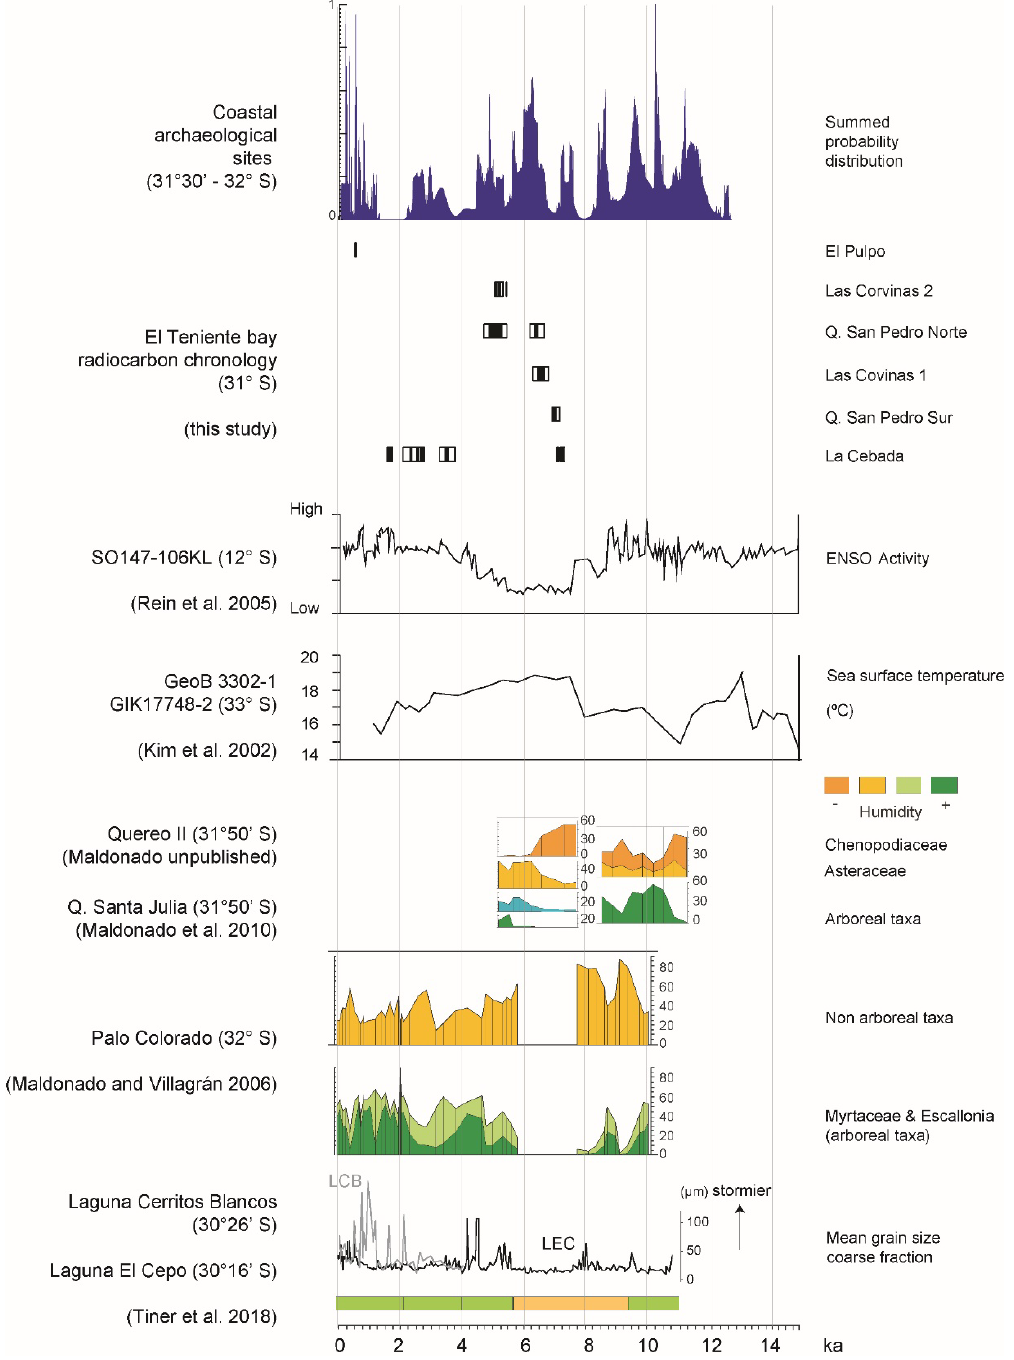
Figure 7. Summary of archaeological chronologies of North-Central Chile and main paleoenvironmental records discussed in this study.